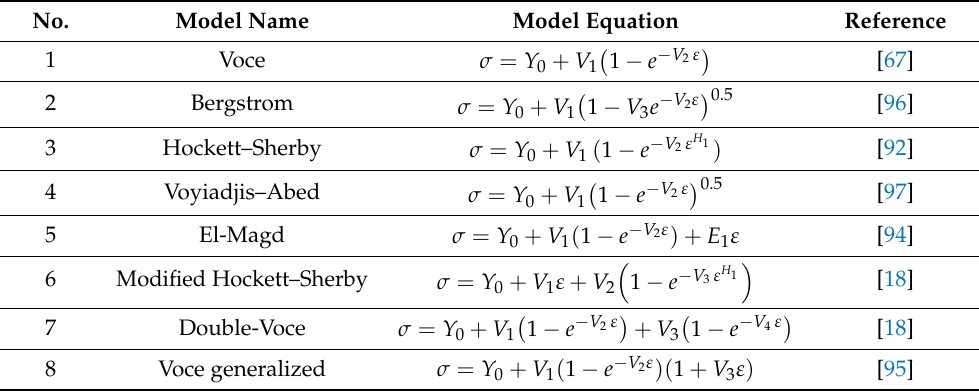
Table 5. Voce’s family flow model with an emphasis on strain